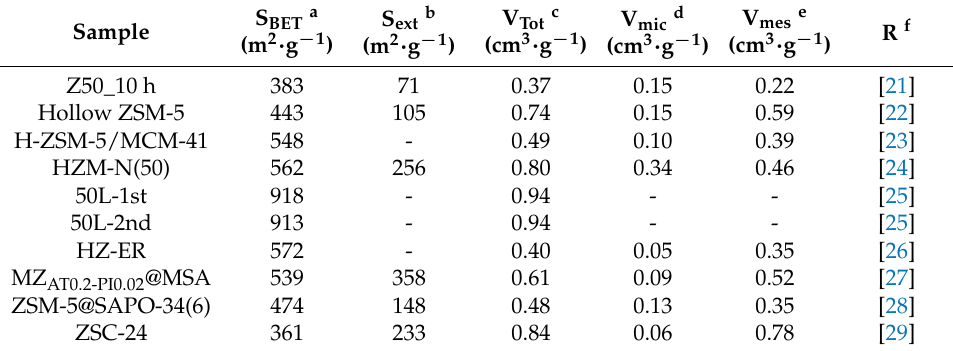
Table 1. Textural properties of ZSM-5 zeolite with special morphology in the references.